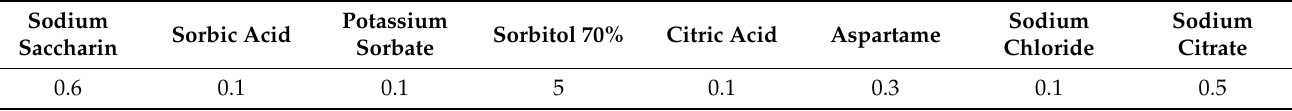
Table 4. Composition of the oral Ra-HCl 25 mg/mL solution (% w / v